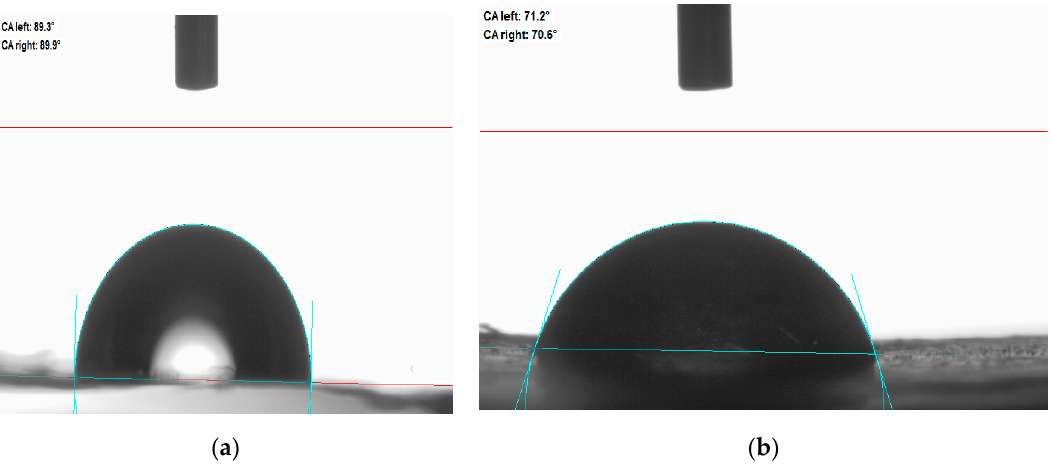
Figure 2. Water contact angle for ( a ) low-density polyethylene (LDPE) and ( b ) prepared bioplastics from S5.